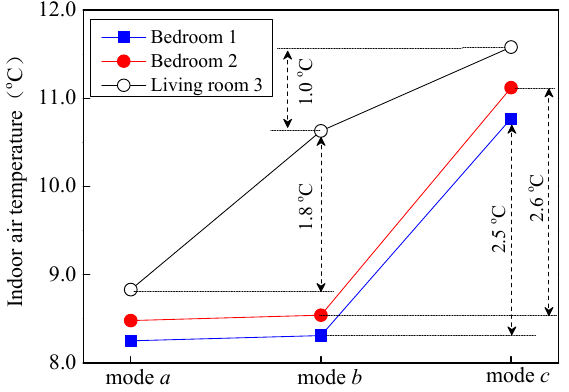
Figure 10. Indoor air temperature of the main rooms in three space-arrangement modes.